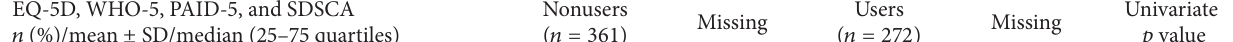
Table 8: Scores on quality of life (EQ-5D), well-being (WHO-5), diabetes-related distress (PAID-5), and self-care behavior (SDSCA). EQ-5D, WHO-5, PAID-5, and SDSCA 𝑛 (%)/mean ± SD/median (25–75